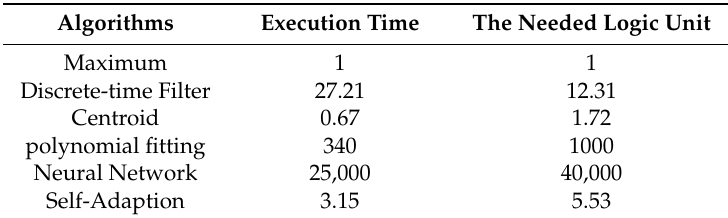
Figure 11. Precision of six peak detection algorithms changing with the variation of SNR. Table 2. Calculation performance of the